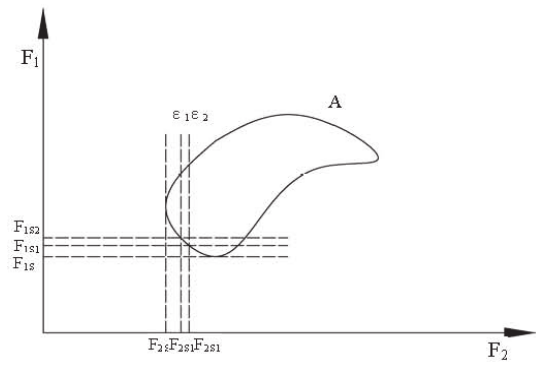
Fig. 3. Geometrical representation of the ε -constraint